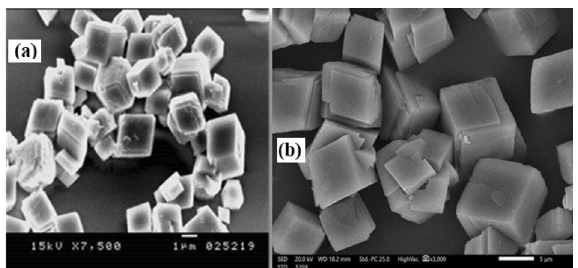
Figure 17. SEM images of CaCO 3 crystals: ( a ) in absence, and ( b ) in presence of copolymer 2